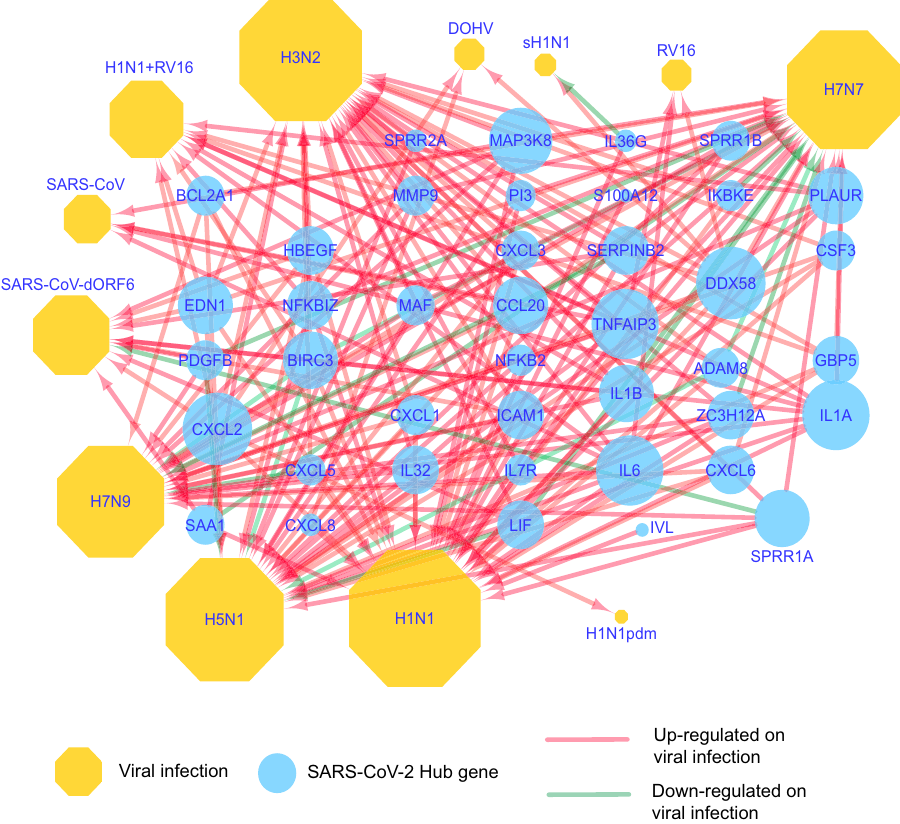
Figure 4. Association of COVID 19 hub genes with other respiratory viral infections. A network generated by use of Cytoscape depicts the expression of COVID-19 hub genes on infection by various respiratory viruses. The green arrows indicate down-regulation, and the red arrows show up-regulation of these